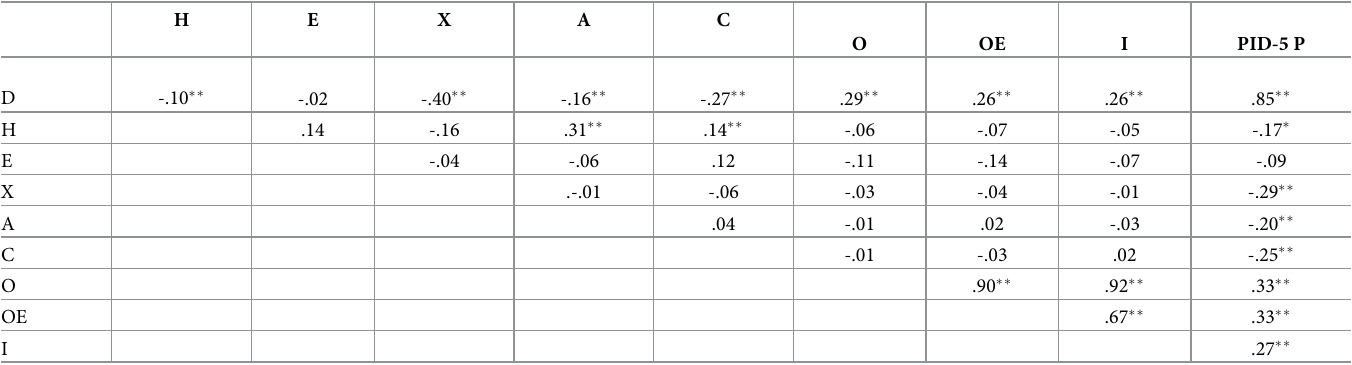
Table 2. Intercorrelations of personality traits assessed by HEXACO PI and DELTA inventory (N = 180).